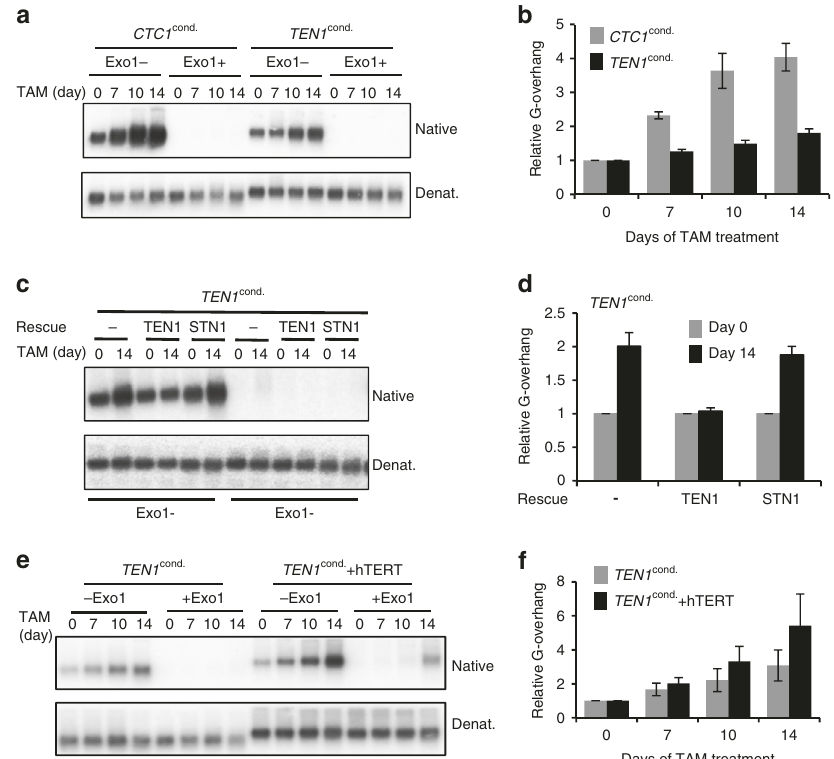
Fig. 2 TEN1 loss causes modest G-overhang elongation. G-overhang abundance was analyzed by in-gel hybridization in the indicated cell lines following various times of tamoxifen (TAM) treatment. a , b TEN1 or CTC1 conditional cells. c d TEN1 conditional cells overexpressing exogenous TEN1 or STN1. e f TEN1 conditional cells with/without hTERT overexpression. a , c , e Gels showing hybridization of TAA(C 3 TA 2 ) 3 probe to genomic DNA under native and denaturing conditions. b , d , f Quanti fi cation of relative G-overhang abundance. Overhang abundance in TEN1 − / − , CTC1 − / − , and TEN1 − / − - hTERT cells was normalized to that of TEN1 F/F , CTC1 F/F , or TEN1 F/F -hTERT cells respectively (i.e., t = 0). Error bars indicate mean ± SEM, n = 3 independent